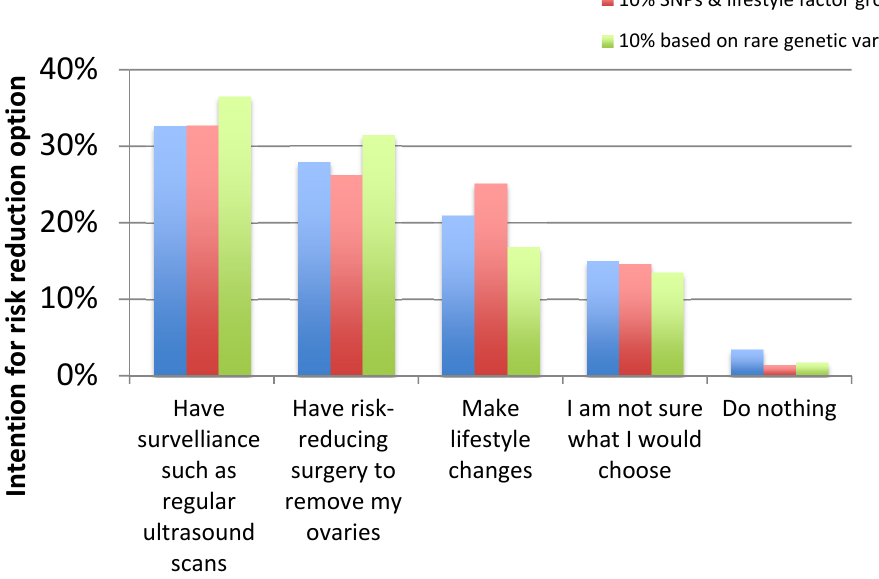
Figure 3. Behavioural intentions after exposure to hypothetical risk scenario compared between groups.